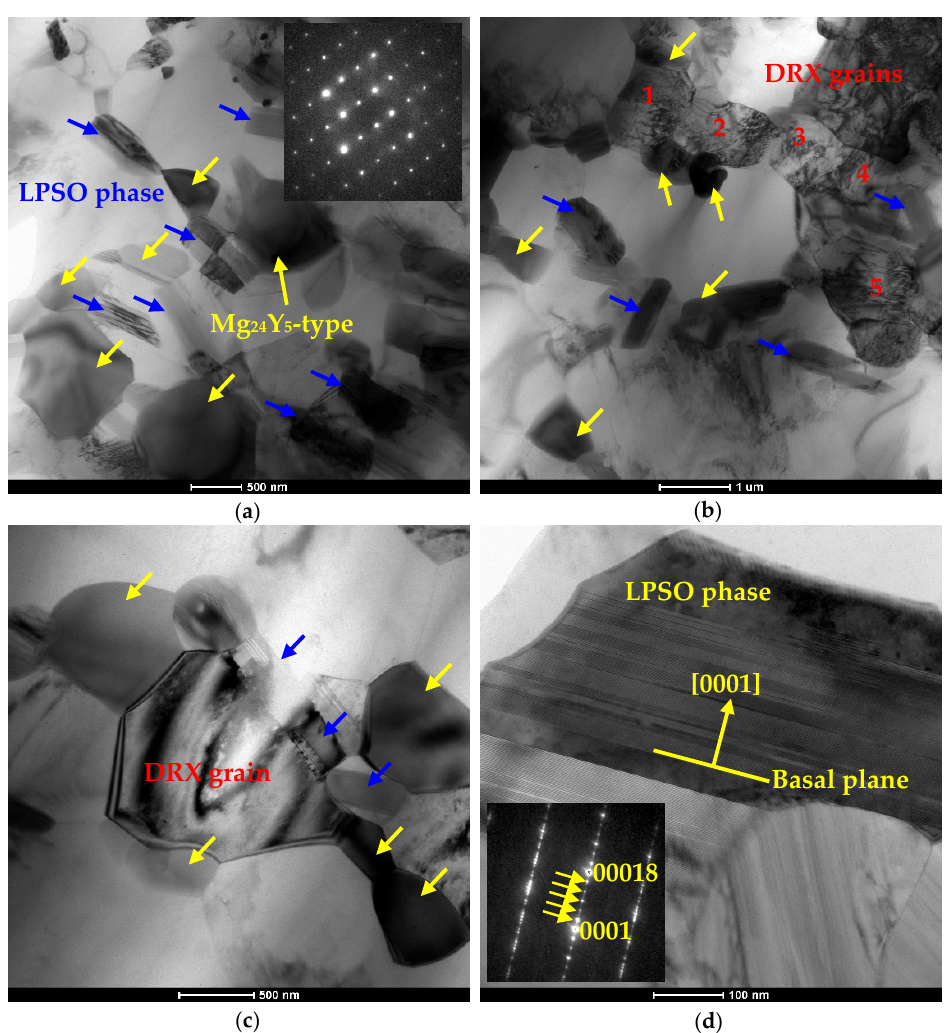
Figure 4. TEM images of ECAP Mg-10Y-6Gd-1.5Zn-0.5Zr alloy. ( a ) Distribution of refined second phase particles and inset was the selected area electron diffraction (SAED) pattern of Mg 24 Y 5 -type phase; ( b ) Mixed region with refined particles and DRX grains; ( c ) A DRX grain surrounded by various particles; ( d ) Morphology of 18R-LPSO structure and inset was its SAED pattern.